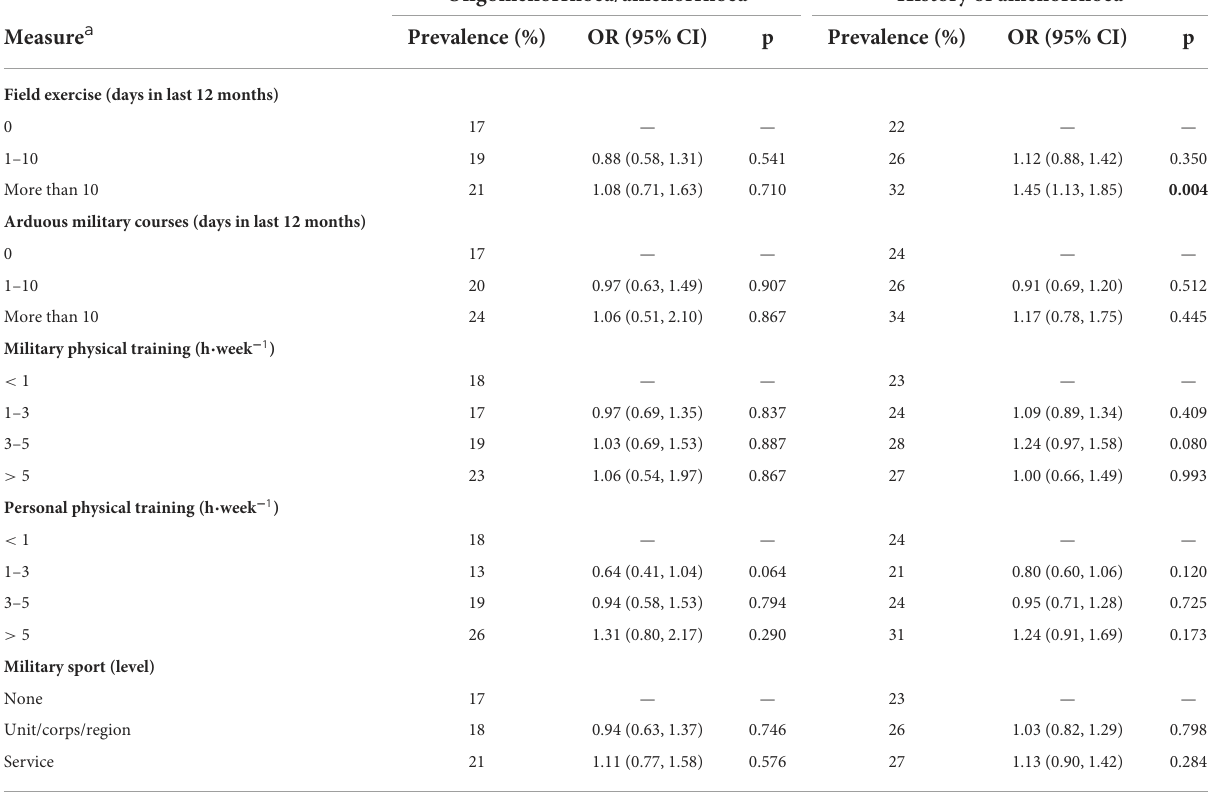
TABLE 5 Associations between exercise behaviors and menstrual function. Oligomenorrhoea/amenorrhoea History of amenorrhoea Measure a Prevalence (%) OR (95%